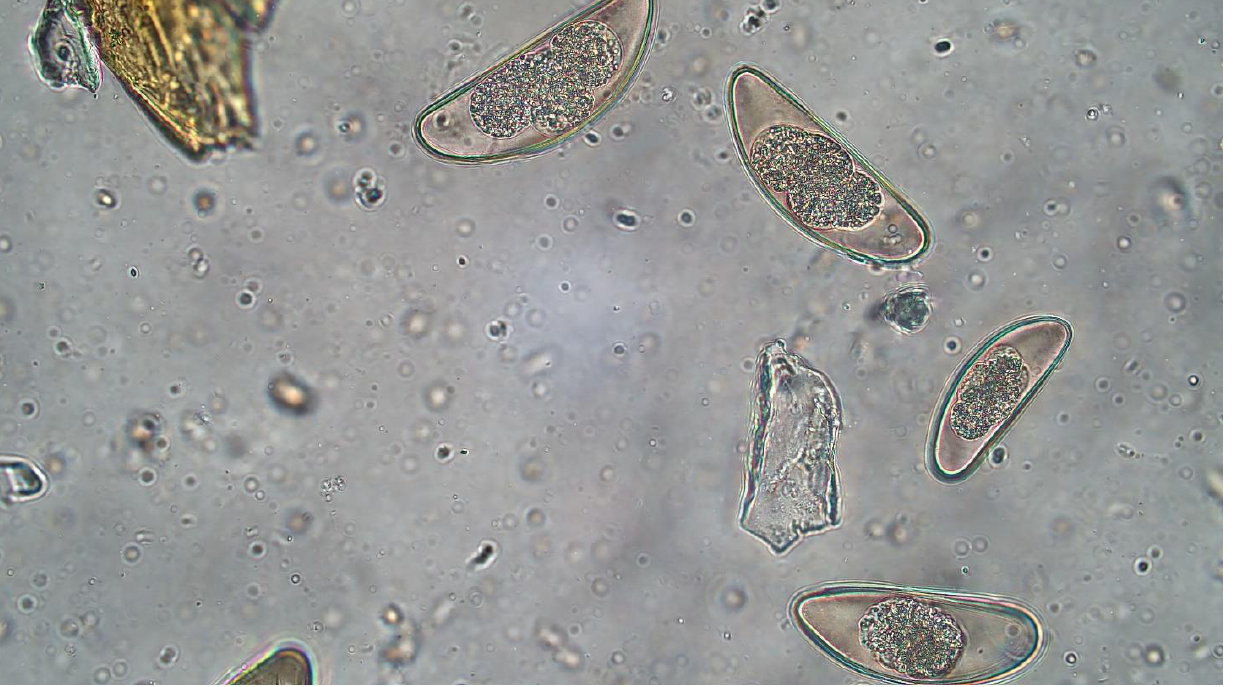
Figure 6. Leidynema appendiculata pinworm eggs found on a floatation of fresh feces from dubia roaches ( Blaptica dubia ) at The North Carolina Museum of Natural Science (Raleigh, NC, USA). Image taken at 400× during pre-treatment screening. Table 1. Dubia roach, Blaptica dubia, 24 hr pre-treatment fecal total wet weight (g) and pinworm ova (#) and adult Leidynema appendiculata (#) confirmed from each roach on necropsy 2 days after fecal collections.